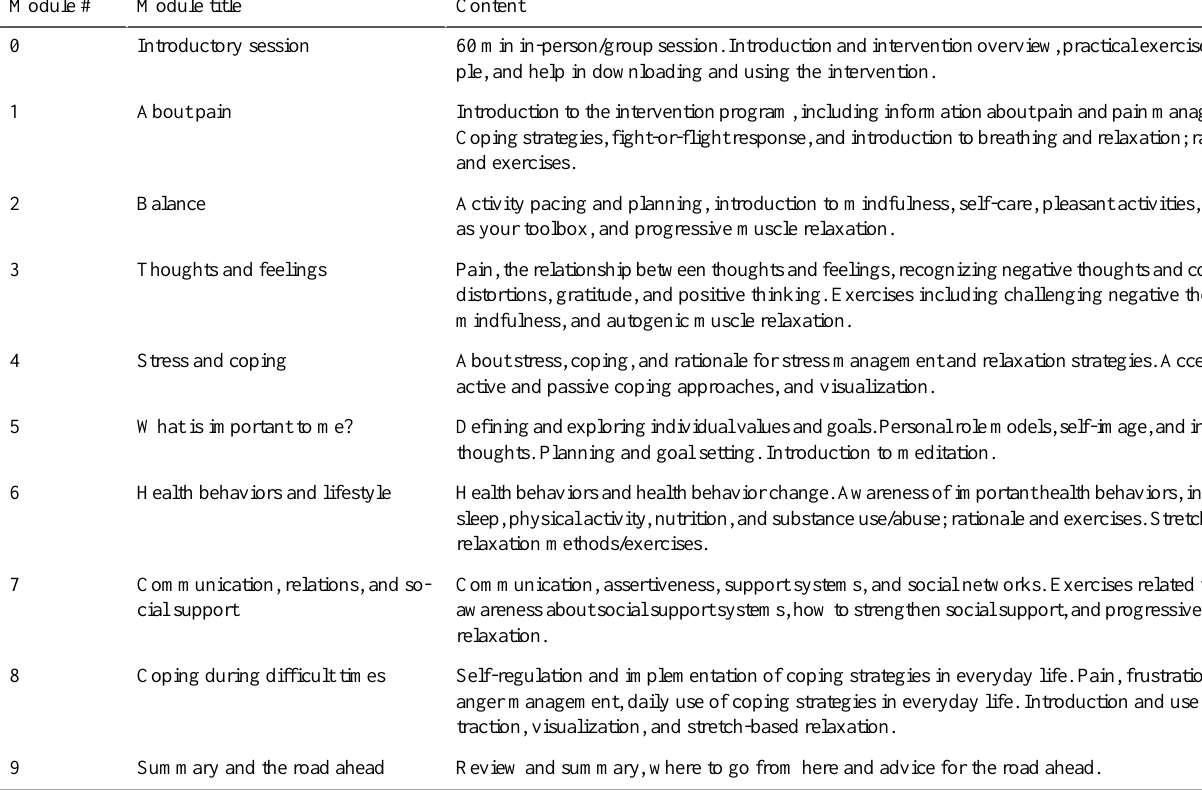
Table 6. Overview of EPIO modules and